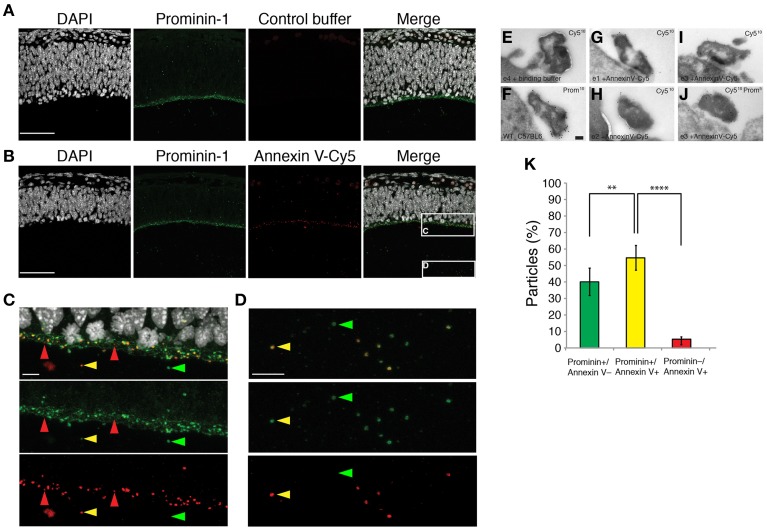
Phosphatidylserine is on the outer-leaflet of the plasma membrane of the released midbody. (A–D) Micrographs of mouse embryonic E11.5 coronal cryosections of dorsal telencephalon injected with either Annexin V binding buffer alone (A) or containing Annexin V-Cy5 (B–D). Sections were consecutively stained by immunofluorescence for prominin-1 (green) and counterstained with DAPI (white). Images are z-projections of 32 consecutive 0.38-μm optical sections. (C,D) Higher magnifications of either the apical plasma membrane of the ventricular zone (C) or particles in the cerebrospinal fluid (D) [regions indicated by the boxes in (B)]. Red arrows, Annexin V-Cy5 single positive particles, green arrows, prominin-1 single positive midbody particles, yellow arrows, Annexin V-Cy5 and prominin-1 double positive midbody particles. Scale bars, 50 μm (A,B) and 10 μm (C,D). (E–J) Ultrathin cryosections of the apical surface of E11.5 mouse telencephalic neuroepithelium immunogold labeled for Cy-5 (E,G–I), prominin-1 (F), or a combination of Cy-5 and prominin-1 (J). Scale bar, 100 nm. (K) Percentage of three different types of particles in the cerebrospinal fluid, classified by decoration with prominin-1 antibody and Annexin V-Cy5. Data are the mean of six 213-μm wide fields from three different embryos and litters; total number of counted particles, 581; error bars indicate SD; **P < 0.01, ****P < 0.0001; unpaired t-test.